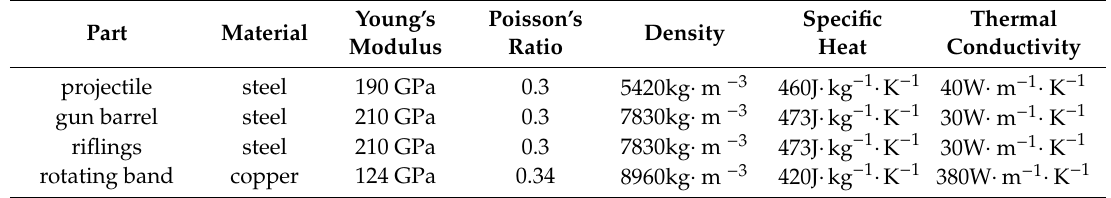
projectile Figure 4. Schematic representation of the energy conversion process. 3.1. Numerical Calculation of E 1 and E 2 As is exhibited in Figure 4, combustion of the propellant produces propellant gas, which is filled in the space from breech to projectile bottom and pushes the projectile to do translational and rotational movement inside the gun barrel. At the same time, the projectile gets translational kinetic energy and rotational kinetic energy. E 1 and E 2 can be expressed by: